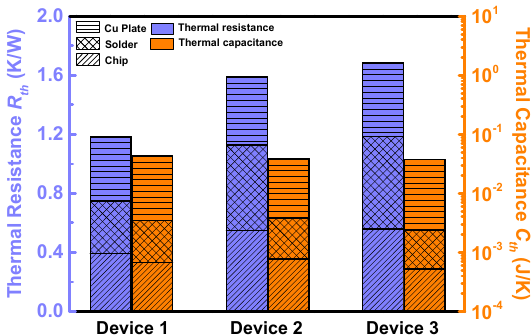
Figure 14. The modified thermal resistance and capacitance of each material layer of the three devices.